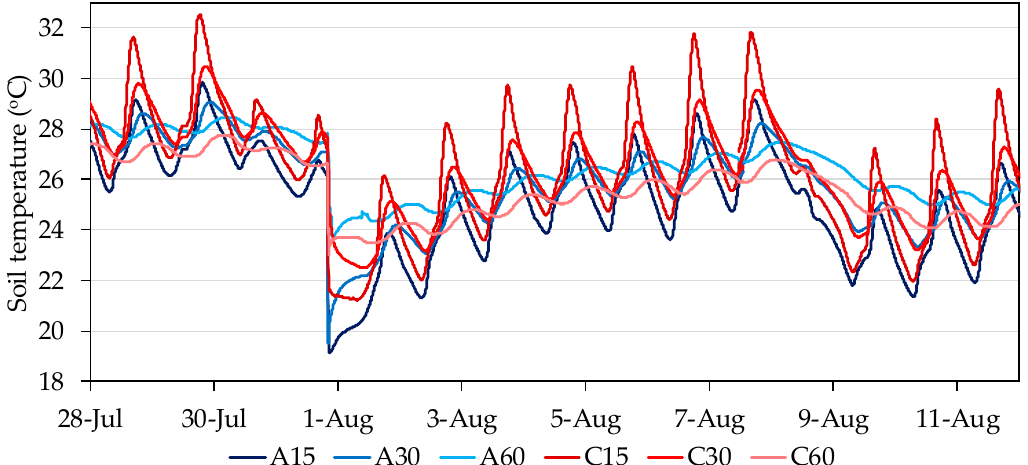
Figure 5. Sample of daily fluctuations in soil temperature at the studied positions and depths in Plot I in July–August 2015.